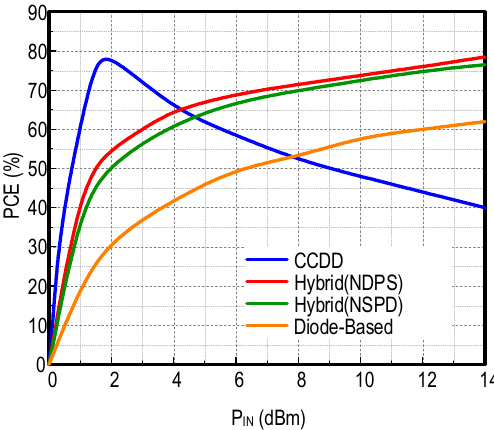
Figure 2. Simulated PCE of the four rectifier configurations [13].